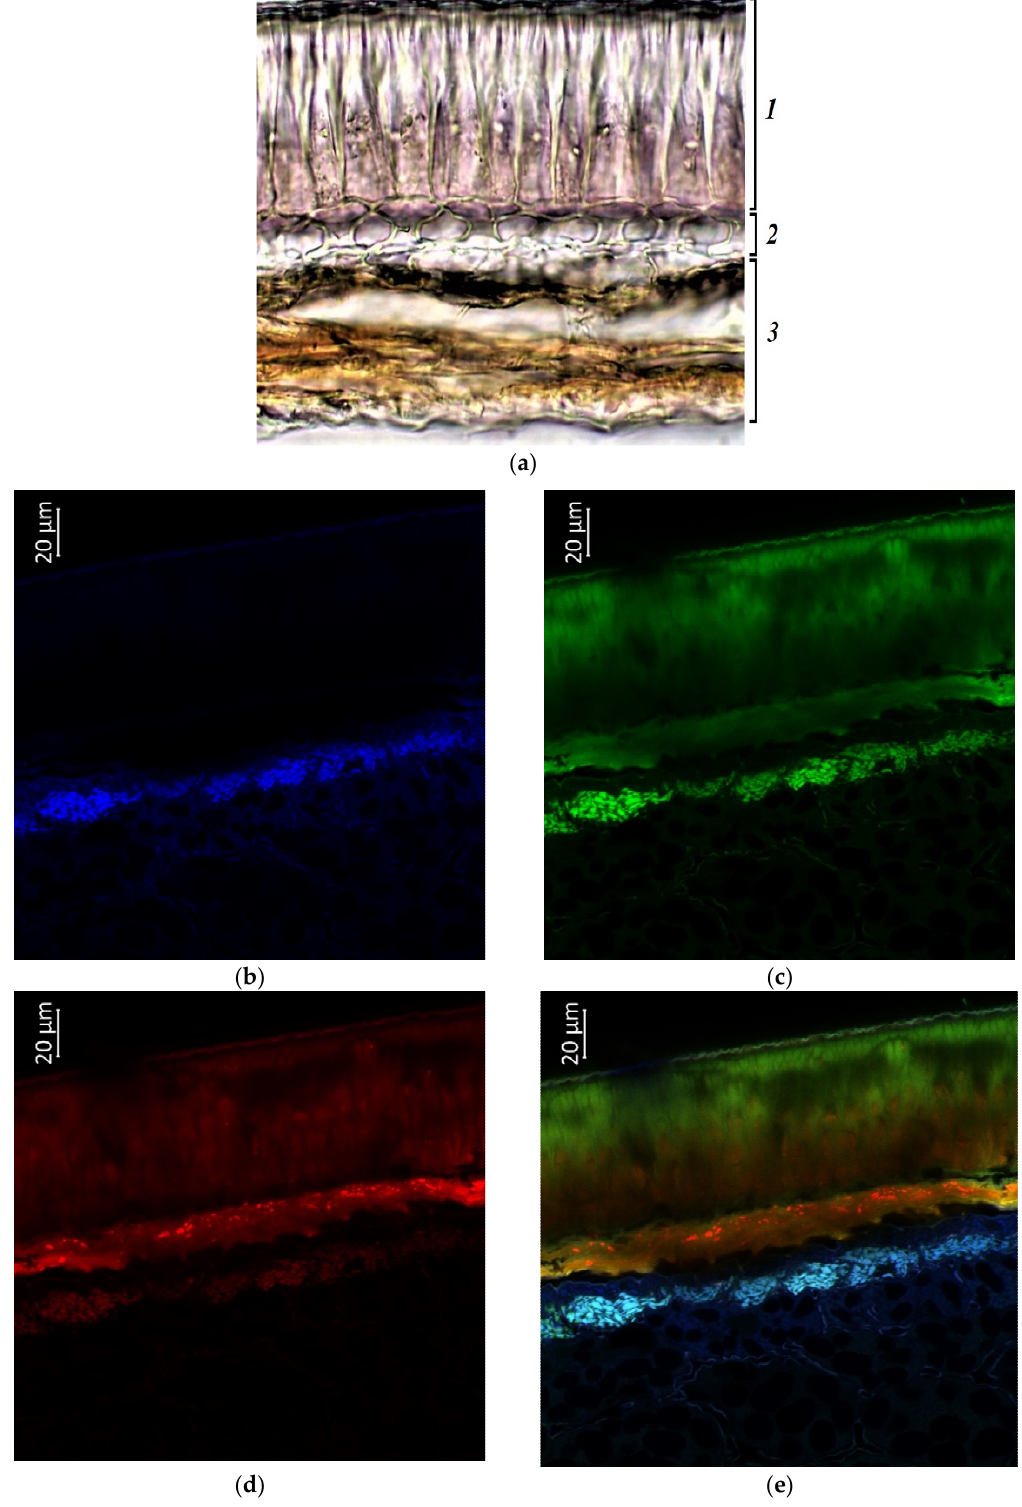
Figure 8. V. unguiculata accession k-6: ( a )—seed coat structure, light microscopy (1—palisade layer, 2—hypoderma, 3—parenchyma); ( b – e ) transverse section of the seed, confocal microscopy, ( b )— excitation 405 nm with the emission in 400–475 nm (blue), ( c )—excitation 488 nm with the emission in 500–545 nm (green), ( d )—excitation 488 nm with the emission in 620–700 nm (red), ( e )—merged. According to confocal microscopy, the cavities and cell walls of the palisade epider- mis of accession k-1783, which had a beige seed color, contained more flavonols and fla- vins than accession k-6 (Figure 9c). The same substances were found in the hypoderma and in several rows of parenchyma cells adjacent to it, as well as in the cells of the cotyle- dons. Anthocyanins and anthocyanidins were located in small inclusions in the cell cavi- ties of the palisade epidermis and hypoderma and in the upper cells of the parenchymal layer (Figure 9d). Quite significant differences between the two grain samples can be noted in the location of phenolic acids. Phenolic acids were almost exclusively in the cot- yledons in accession k-6 (Figure 8b), and the same acids were in the cotyledons and in the cells of the parenchyma of the seed coat in accession k-1783 (Figure 9b).